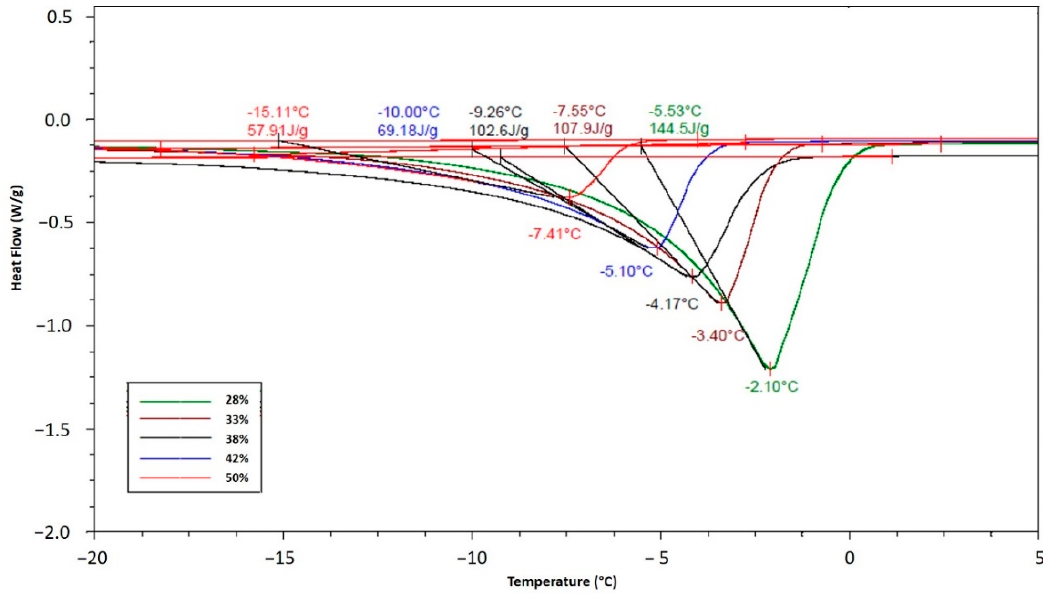
Figure3. T C valuesdeterminedbyDSCanalysisatdi ff Figure 3. T C values determined by DSC analysis at different solid concentrations in the ice cream mixture. Figure 3. T C values determined by DSC analysis at different solid concentrations in the ice cream mixture.